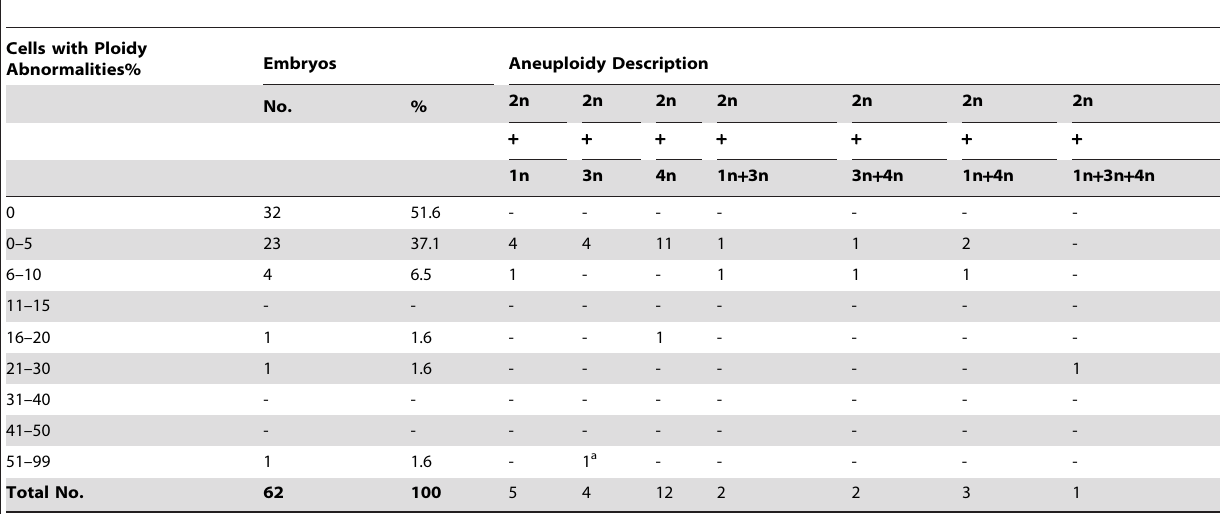
Table 4. The incidence and description of ploidy abnormalities in pig embryos detected by FISH.